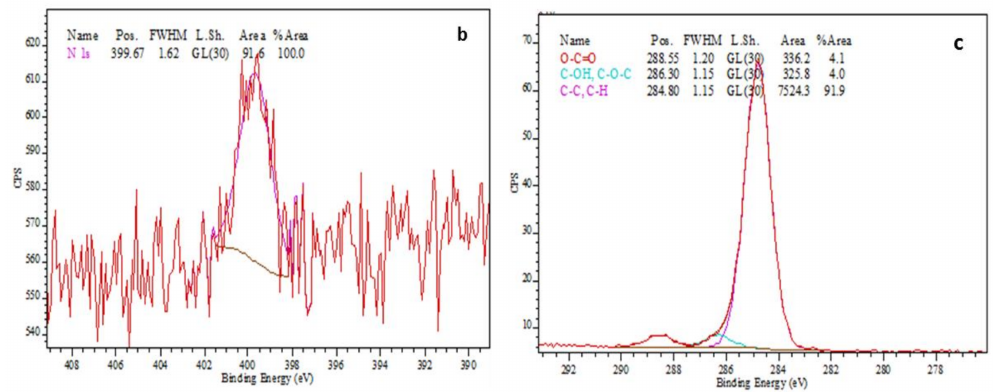
Figure 5. The XPS spectra of TiO 2 nanotube arrays: ( a ) Wide range survey spectra; ( b ) High resolution XPS spectra over N 1s peak at 399.67 eV; and ( c ) High resolution XPS spectra over C 1s peak.